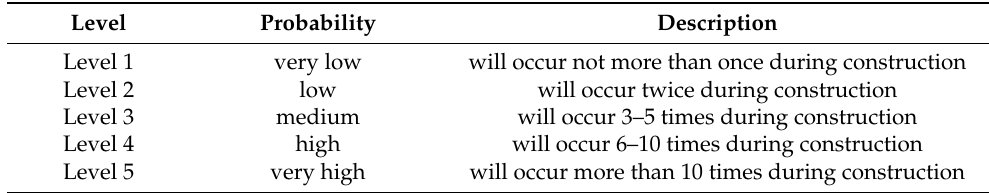
Table 6. Qualitative description of the probability scale in port construction project.